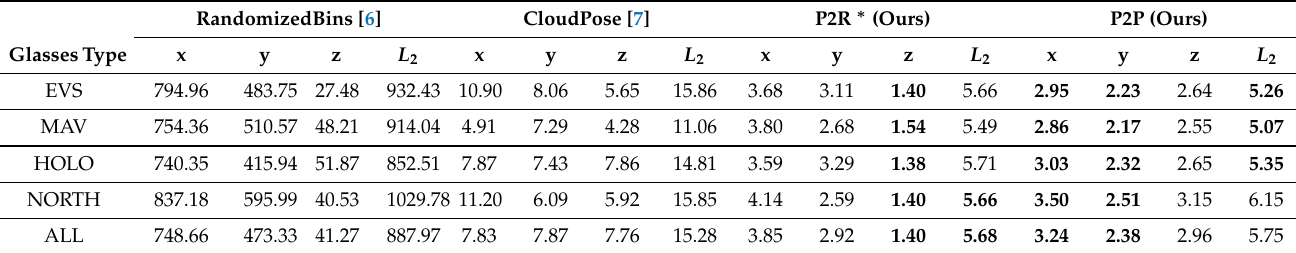
Table 4. Results for the positional, Euclidean error on both approaches compared to RandomizedBins and CloudPose in millimeters. The Everysight Raptor is referenced as EVS, Hololens 1 as HOLO, North Focal Generation 1 as NORTH and the Mini Augmented Vision glasses as MAV. ALL stands for all glasses combined.ree axes are given on the defined metrics. The lowest values among all methods per metric on each individual axis is highlighted.